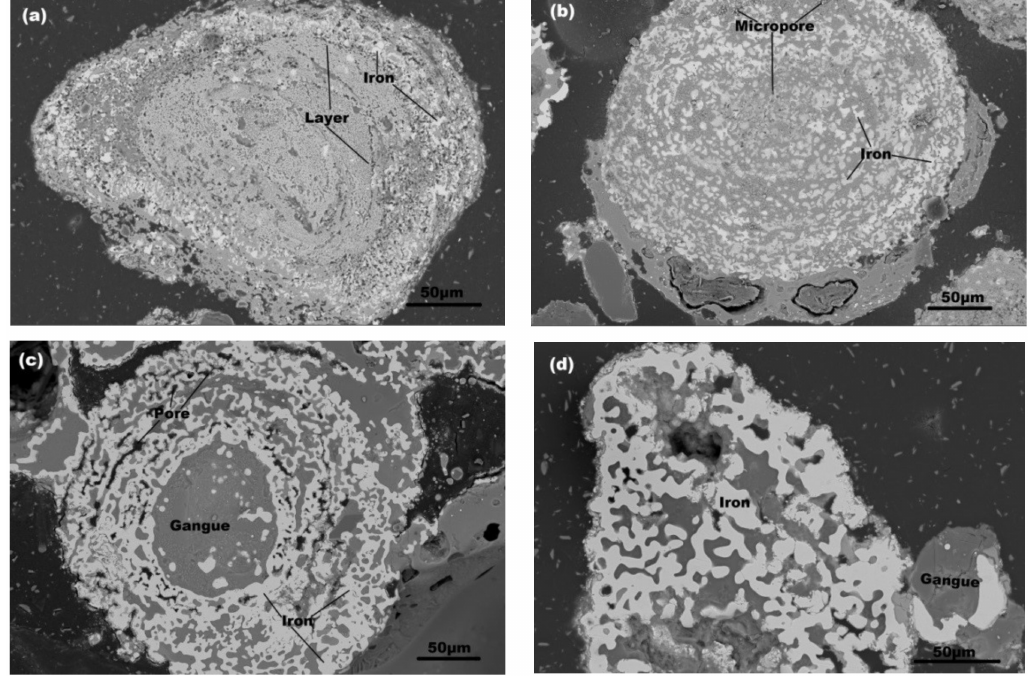
Figure 4. SEM images of iron particles of reduced briquettes at 1423 K for different reduction